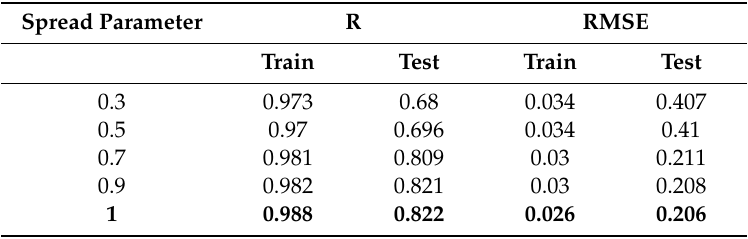
Table 3. Results from tuning radial basis function neural network (RBFNN)